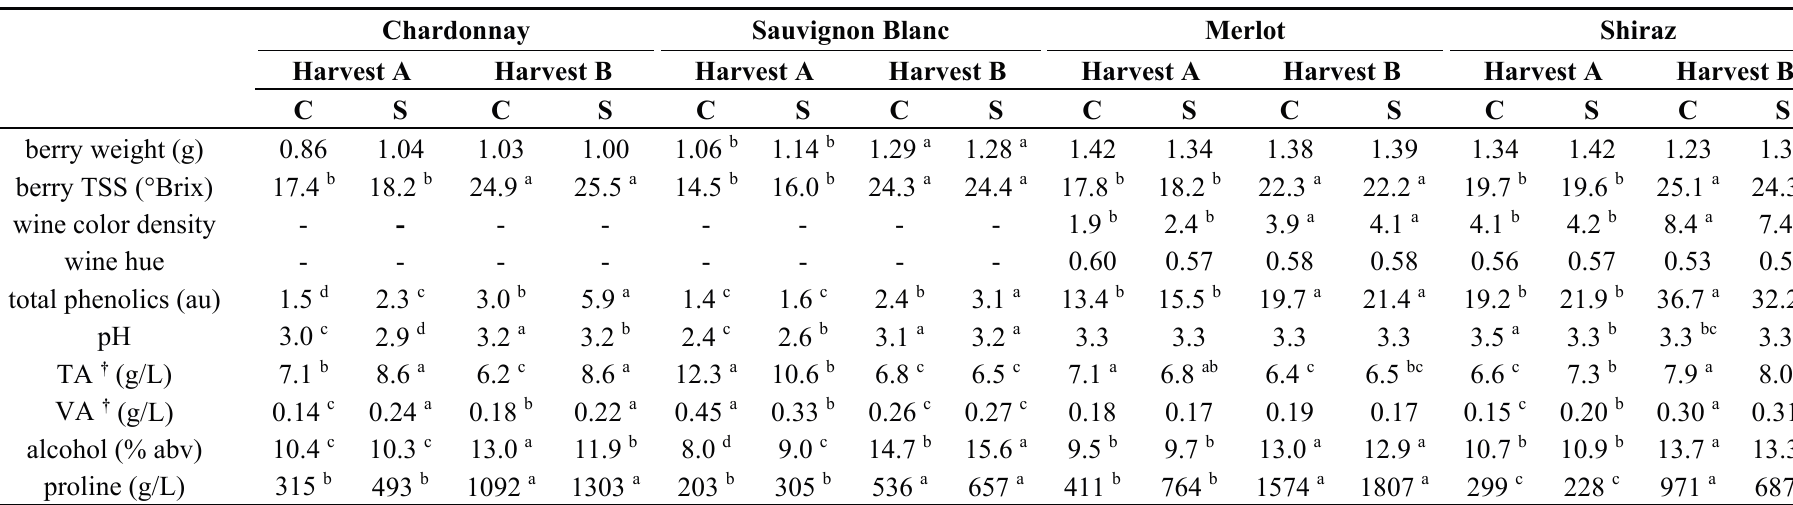
Table 1. Berry weight and TSS of control and smoke-affected Chardonnay, Sauvignon Blanc, Merlot and Shiraz grapes, and color density, hue, total phenolics, proline, pH, titratable acidity (TA), volatile acidity (VA) and alcohol content of corresponding